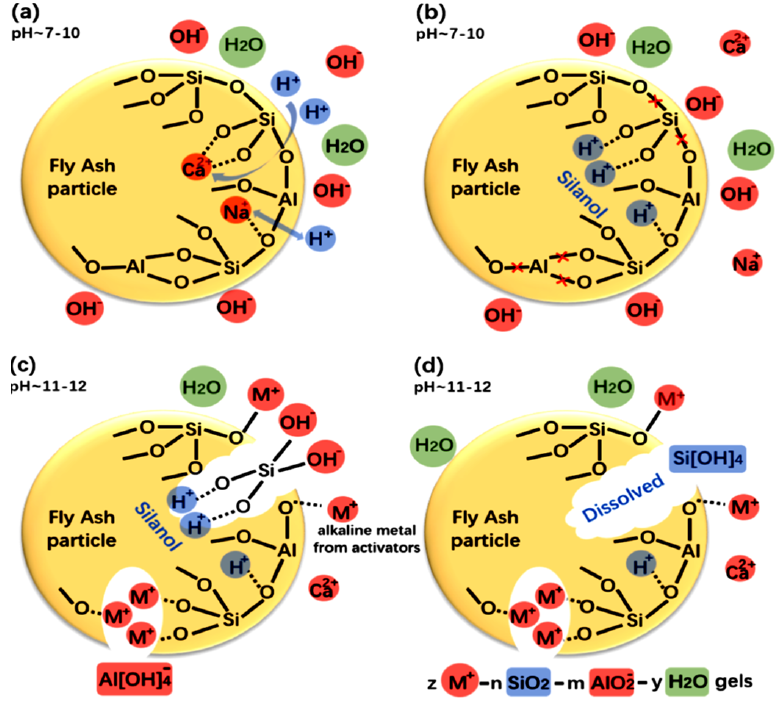
Figure 16. The process of alumino ‐ silicate glass dissolving during the initial stages of reactivity of a one ‐ part GP blend. ( a ) H + exchange for Ca 2+ and Na + , ( b ) dissolution of Al–O–Si bonds, ( c ) depolymerization of the glass network, and ( d ) Si and Al release. Adapted from [206,207].